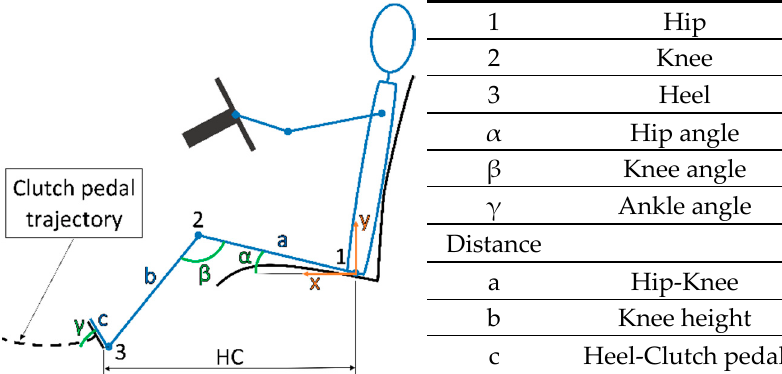
Figure 8. Driver seat position variables.